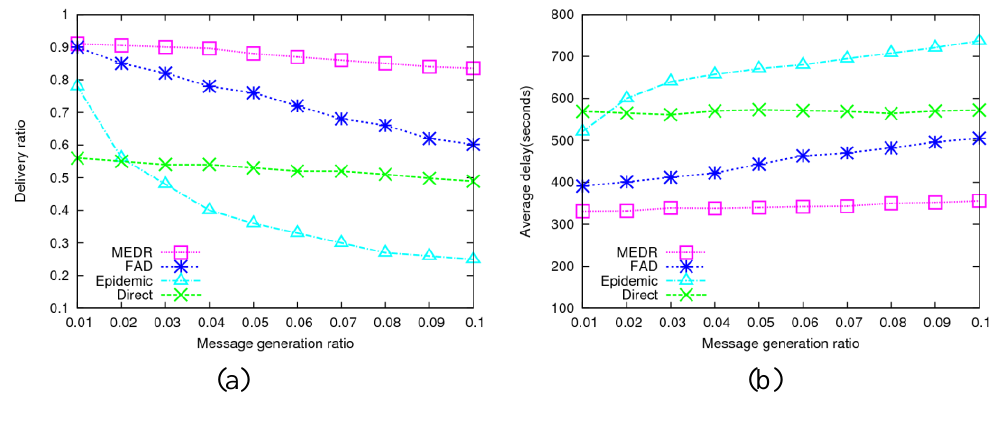
Figure 4. Impact of message generation ratio. (a) Average delivery ratio; (b) Average delay.